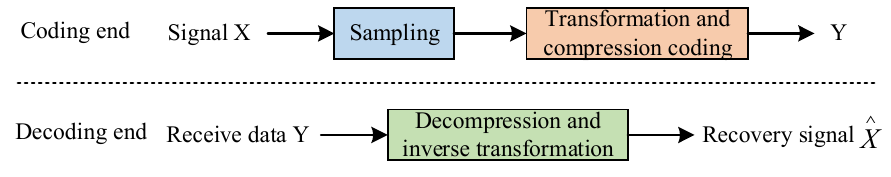
Figure 1. Block Diagram of Image Decoding.